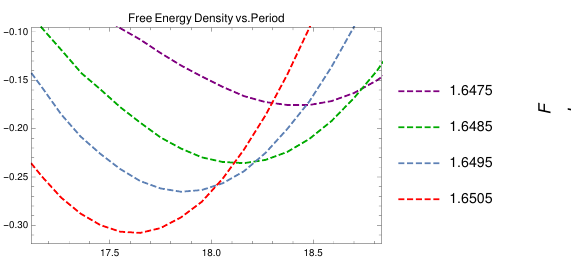
Figure 3b. Free energy density F=L vs. mag- netic (cid:12)eld h for chemical potential (cid:12)xed at (cid:22) = 1 :